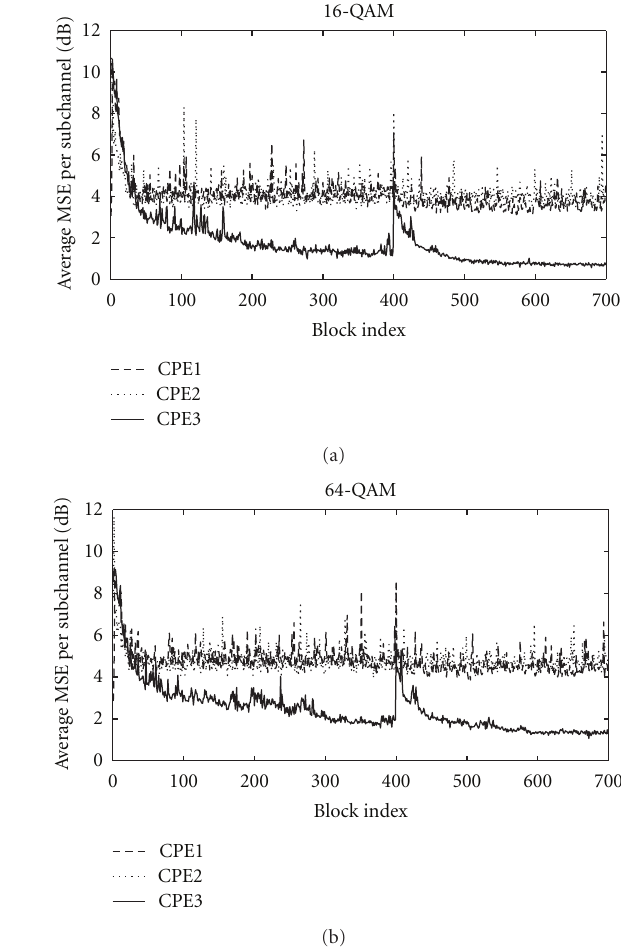
Figure 7: E ff ect of modulation constellation size on algorithm performance curves (16-QAM (top plots), 64-QAM (bottom plots), λ = 0 .